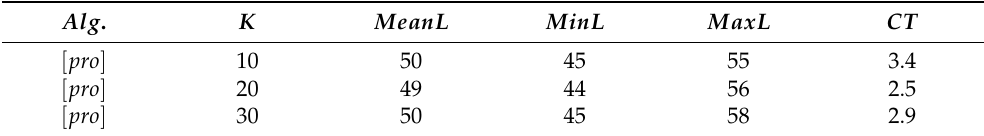
Table 4. MATLAB simulation results with varying K (scenario